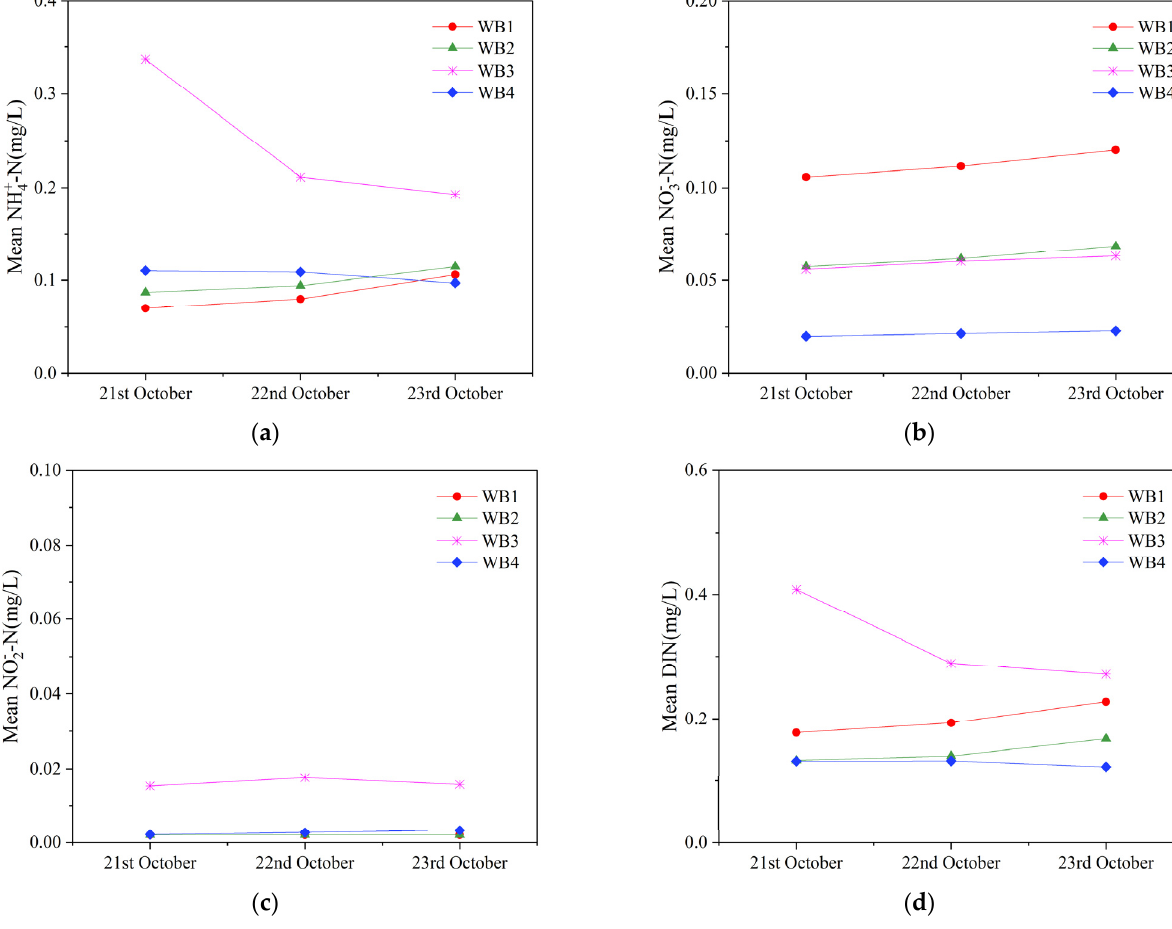
Figure 7. Variations in daily mean inorganic nitrogen concentrations in the river water and the riparian groundwater over the study period from 21 to 23 October 2021: ( a ) ammonia nitrogen, NH + ; ( b ) nitrate nitrogen, NO − ; ( c ) nitrite nitrogen, NO − ; ( d ) dissolved inorganic nitrogen, DIN.